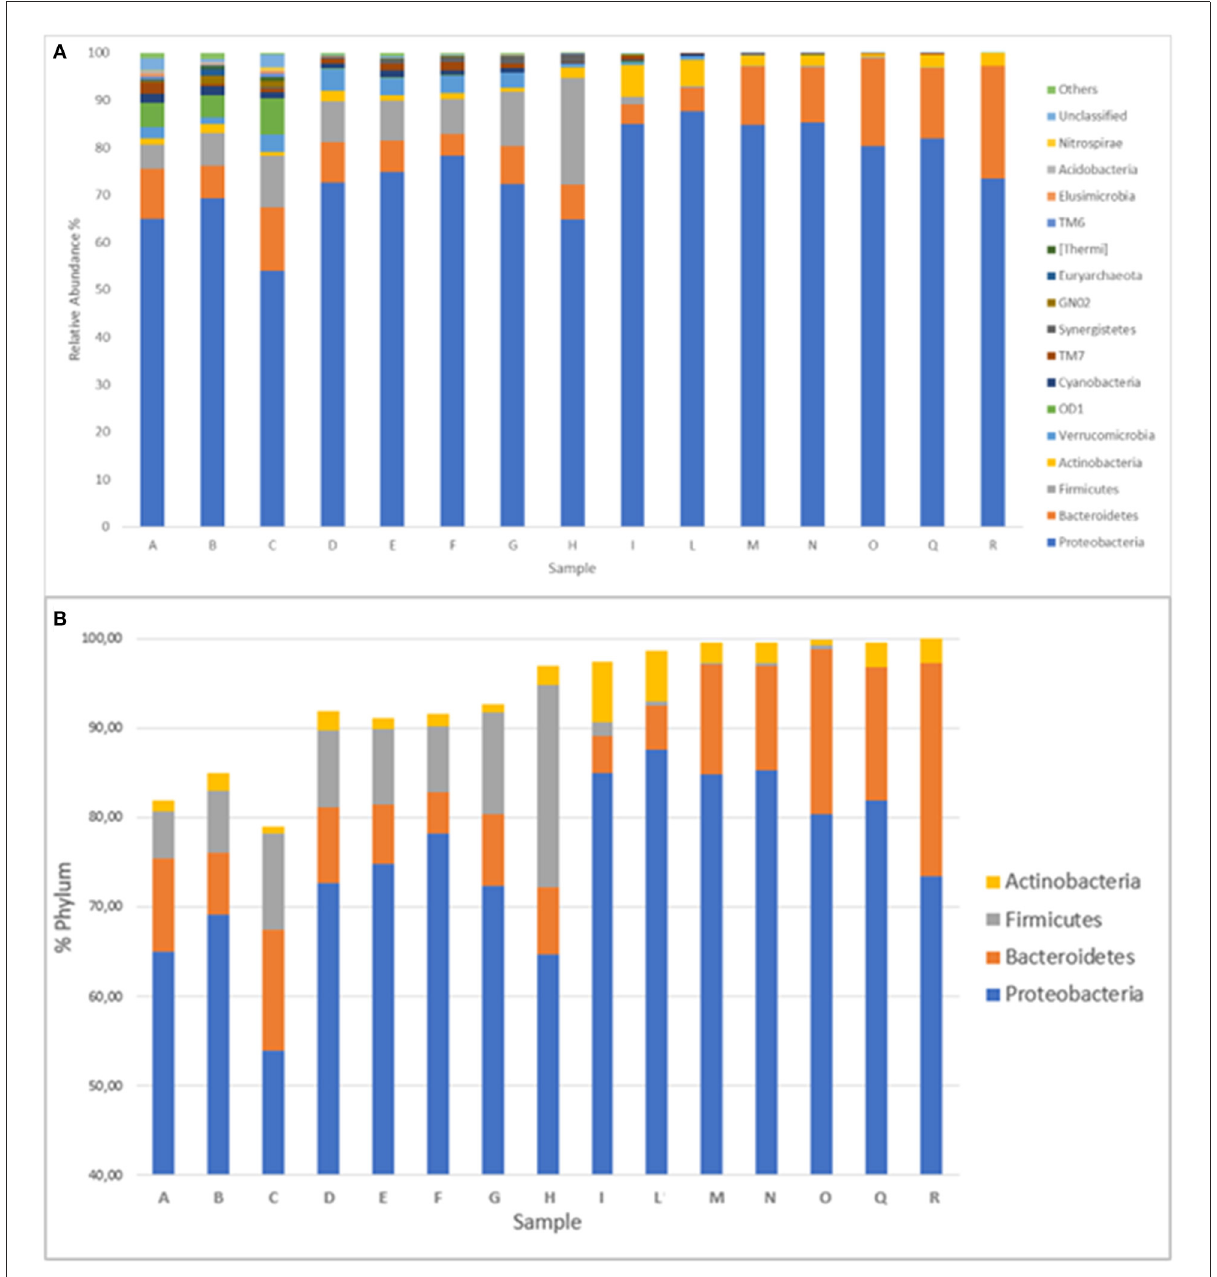
FIGURE2 (A) Distribution of the 16 phyla identified in at least a percentage higher than 0.5% in at least one sampling point. Phyla with a lower percentage are grouped under the category “others.” (B) Distribution of the presence of the four main phyla ( Proteobacteria , Bacteroidetes , Firmicutes , Actinobacteria ) in the 15 sampling